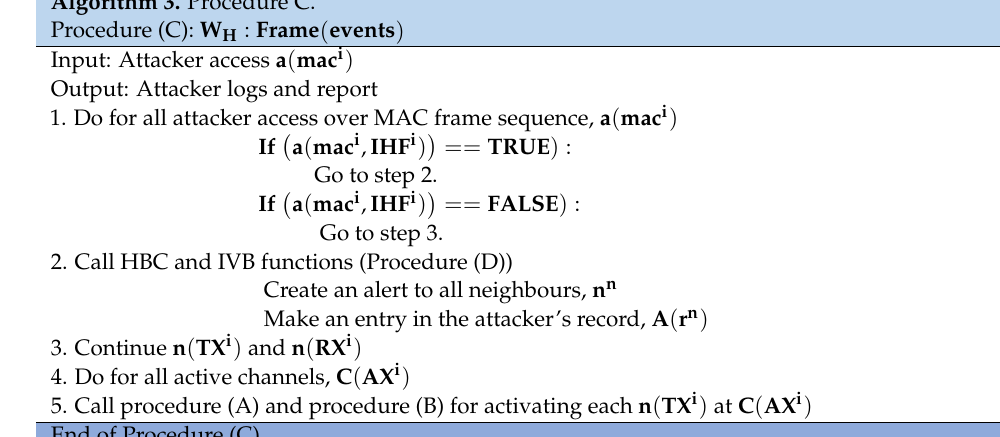
Algorithm 3. Procedure C.